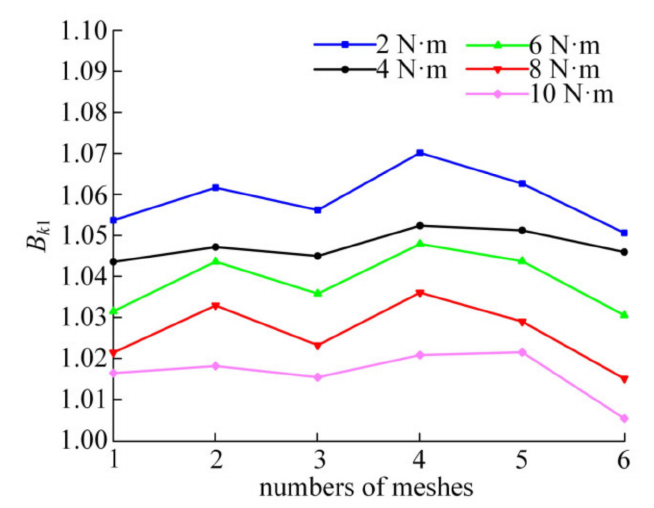
Figure 4. The variation curves of the load proportional coefficient under different load